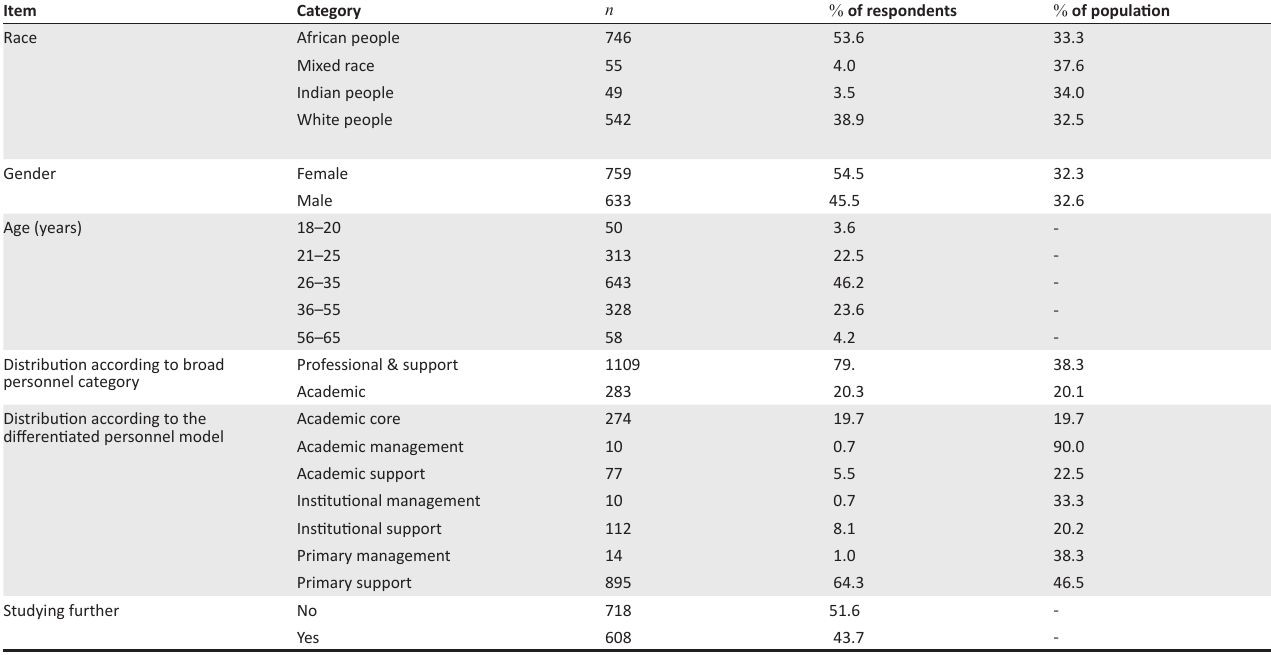
TABLE 2: Characteristics of the study